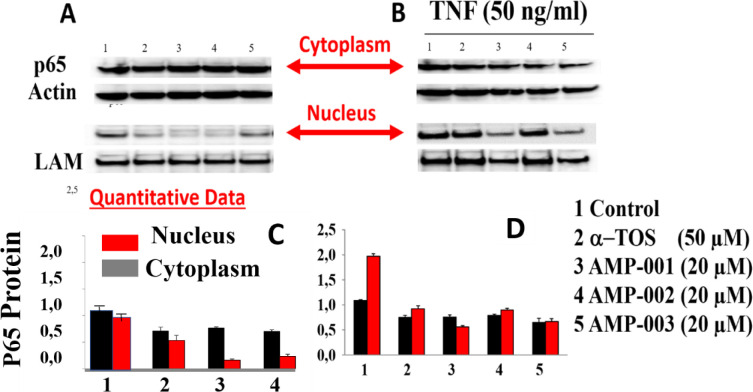
A) Translocation of p65 in MDA-MB-231 cancer cells from nucleus to cytoplasm by Western Blotting (See arrow) post treatment by AMP-001/002/003, B) Deliberate treatment of MDA-MB-231 cancer cells with Alfa-TNF, NF-kB activator followed by translocation of p65 from nucleus to cytoplasm for control compared to AMP-00/003 treatment in presence of Alfa-TNF (and C) quantitative data on p65 translocation from nucleus to cytoplasm-hallmark of NF-kB inhibition, D) p65 protein translocation in presence of Alfa-TNF for AMP-001, AMP-002 and AMP-003.